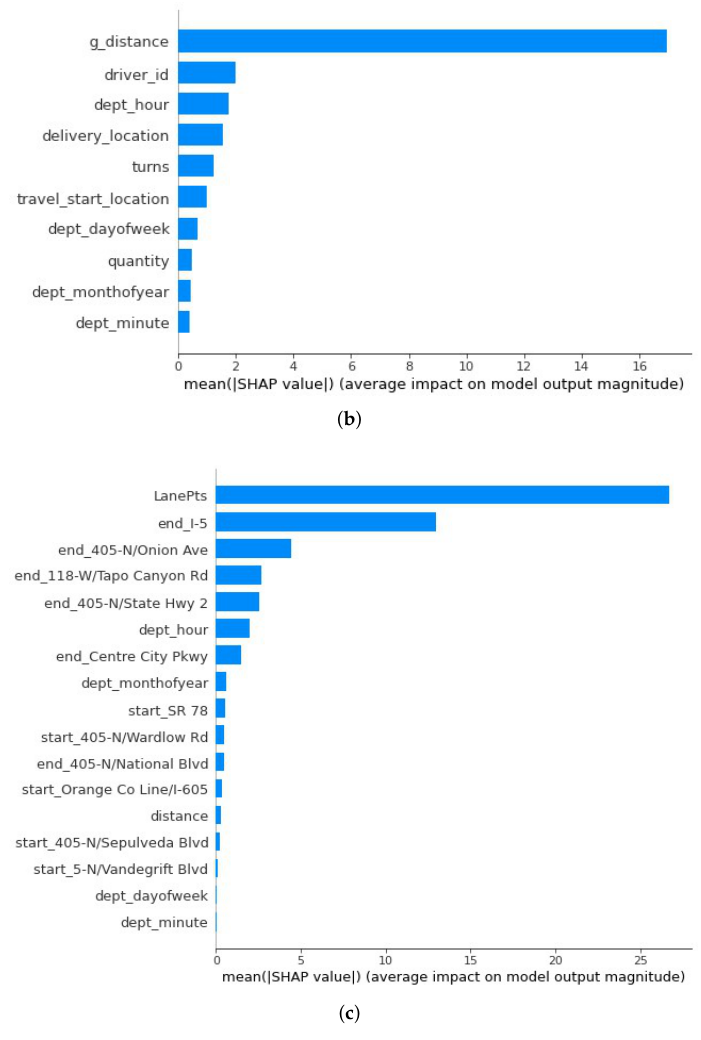
Figure 5. Overall Impact of Features on Model Outcomes, Summary Plots for the LSTM model and the Data Sets NextUp-1, NextUp2, and PeMS. ( a ) Summary plot Dataset-1. ( b ) Summary plot Dataset-2. ( c ) Summary plot PeMS